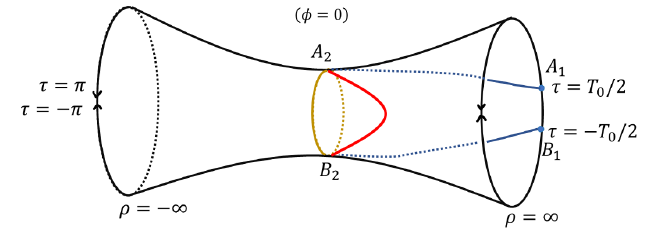
Figure 6 . The configurations of CWES of time-like interval in global AdS 3 spacetime. The blue curves and red curve stand for space-like and time-like segments of CWES of global AdS 3 spacetime. The golden circle stands for the another time-like geodesic locates at the throat ρ = 0